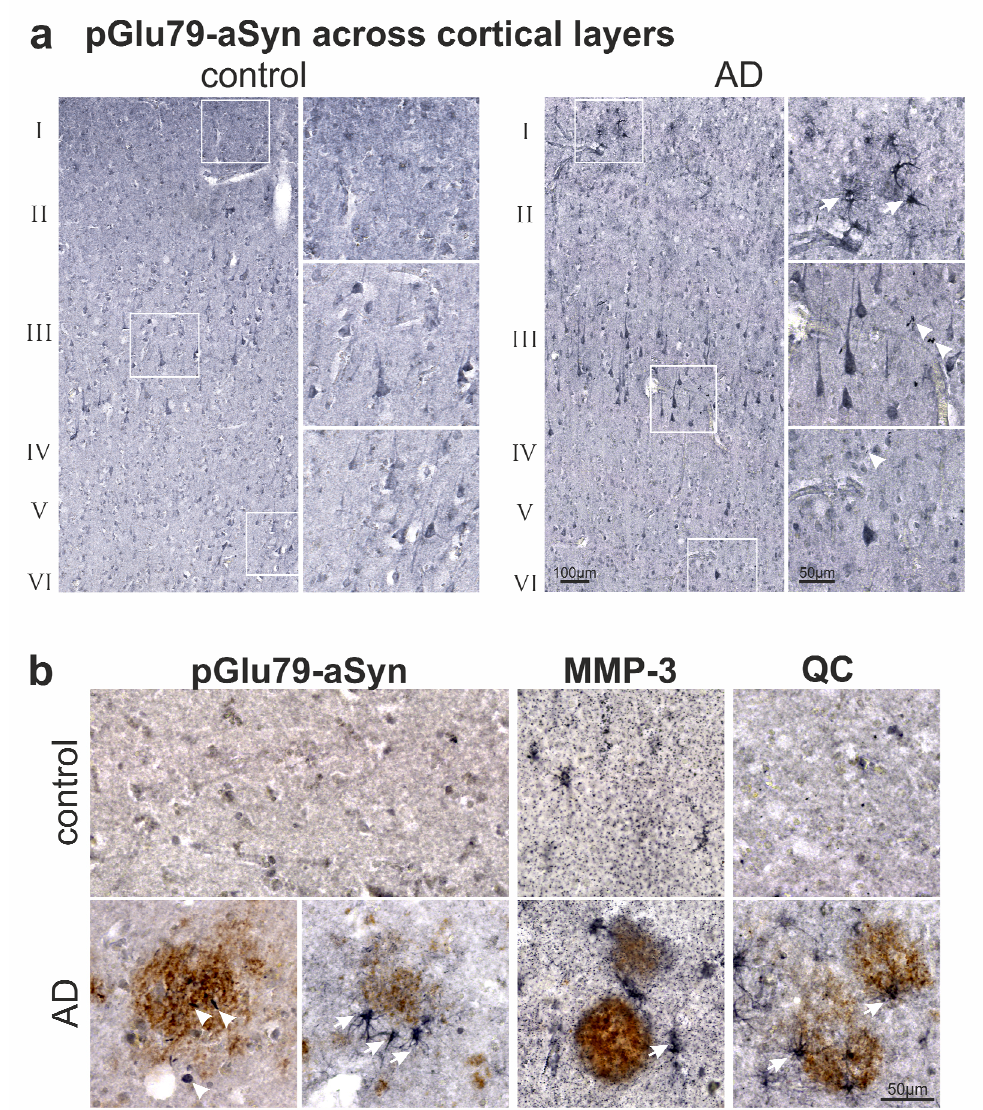
Figure 5. Association of pGlu79-aSyn, MMP-3 and QC with amyloid plaques in human brain tissue. ( a ) pGlu79-aSyn immunoreactivity in neocortex of a control subject (left) and of an AD case (right). The higher magnification images depict layers I, III and VI as indicated by boxes. Note the strong pGlu79-aSyn immunoreactivity in pyramidal neurons, which appears to be more distinct in AD compared to control tissue. The higher magnification images identify glial (arrows) and dot-like (arrowheads) pGlu79-aSyn immunoreactivity. ( b ) Double labelings revealed the glial presence (arrows) of pGlu79-aSyn, MMP-3 and QC (DAB-Ni, black) in proximity of A β plaques (DAB, brown) in AD temporal cortex (Brodmann area 22). In addition, pGlu79-aSyn immunoreactivity was found in rod-like and punctate (arrowheads) structures within A β plaques.